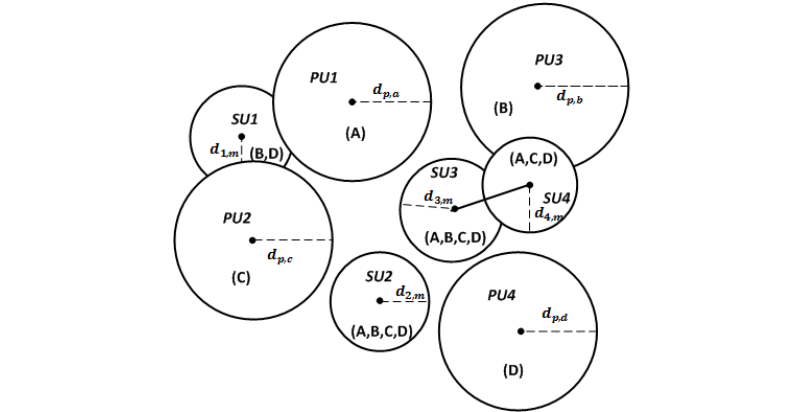
Figure 1. Graph-based System